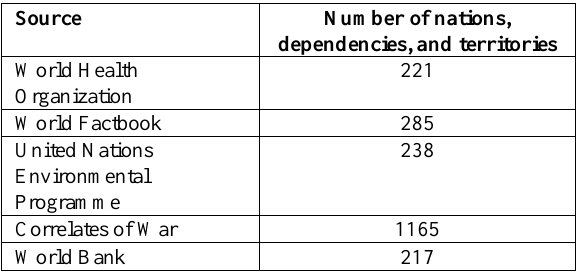
Table 1. Number of countries by